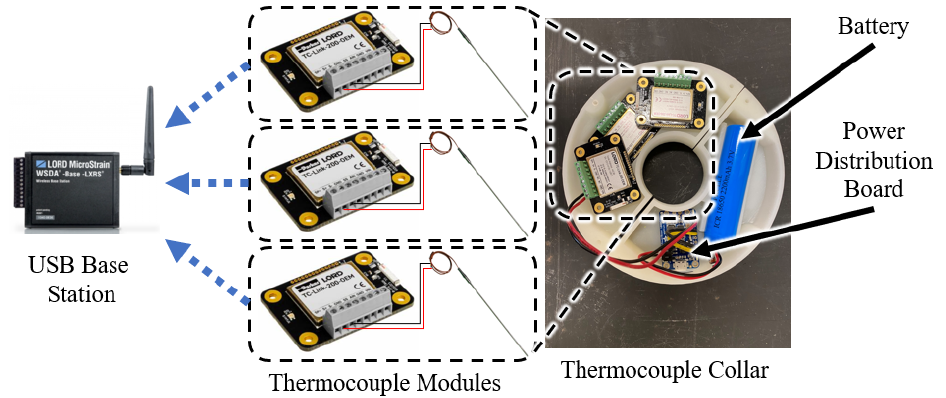
Figure 5. The thermocouple collar with wireless thermocouple transmitters, battery, power distribu- tion board, and USB Base